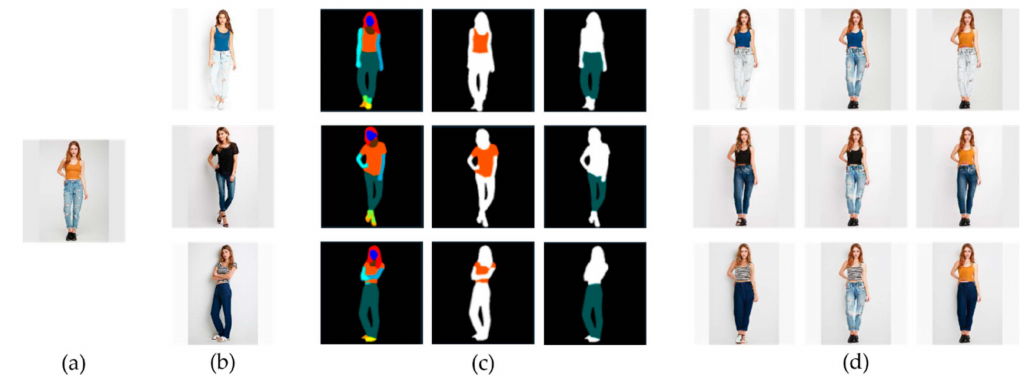
Figure 10. Change the clothes that ( a ) is wearing to ( b )’s. ( c ) is the parts of the style to modify. ( d ) shows the results.